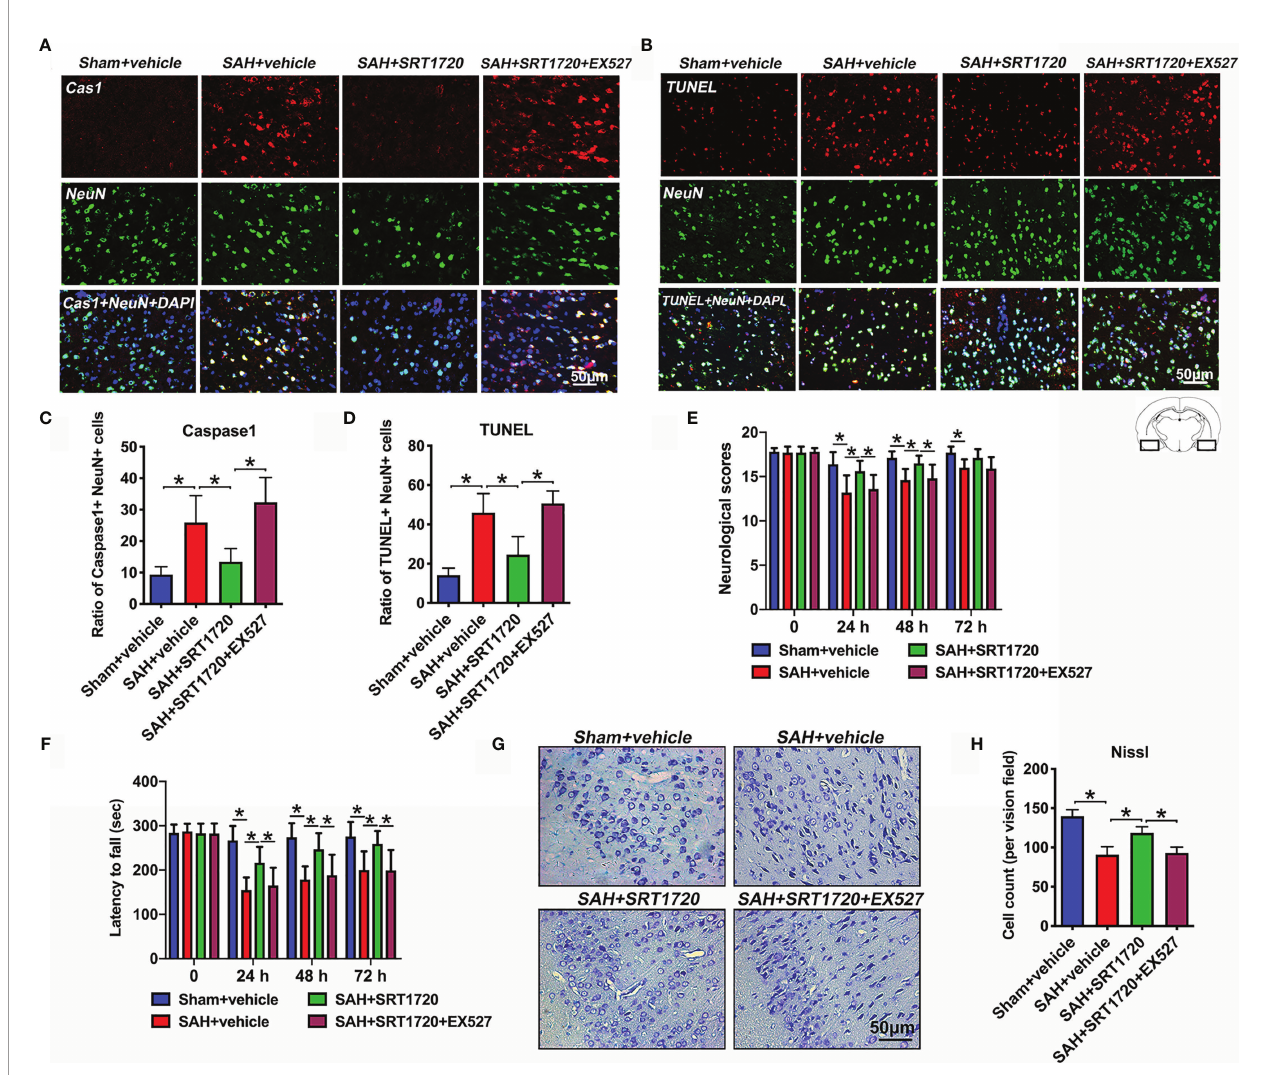
FIGURE 7 | Effects of SRT1720 on neuronal cell death and neurological function after SAH. Representative photomicrographs (A, B) and quanti fi cation of caspase-1 (C) and TUNEL (D) staining. For histopathology studies, the basal temporal lobe adjacent to the clotted blood was evaluated. Effects of SRT1720 on neurological scores (E) and rotarod performance (F) . Representative photomicrographs of Nissl staining (G) and quanti fi cation of the proportion of surviving neurons (H) at 72 h after SAH. Bars represent the mean ± SD. * P <